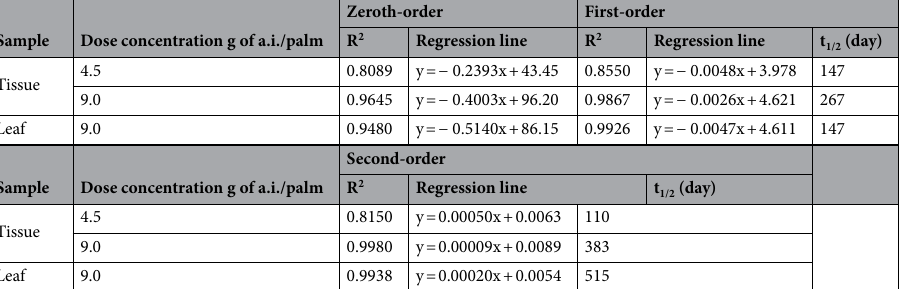
Sample Dose concentration g of